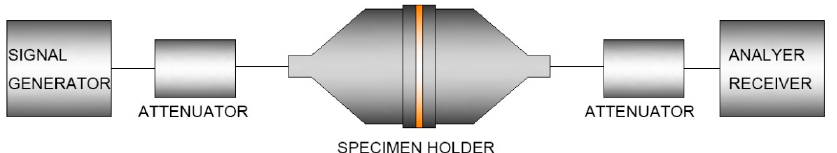
Figure 1. Schematic diagram of flange coaxial transmission line device for electromagnetic interference (EMI) shielding effectiveness (SE) test.